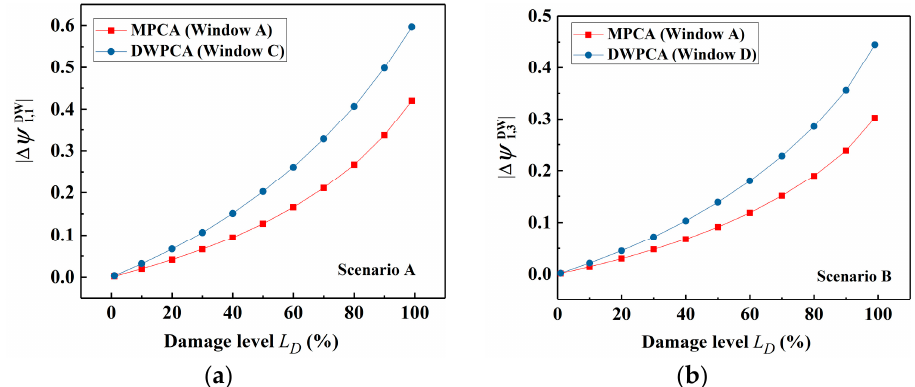
Figure 12. Variation of the absolute value of the CEVs with damage level by MPCA and DWPCA: ( a ) Scenario A; ( b ) Scenario B.